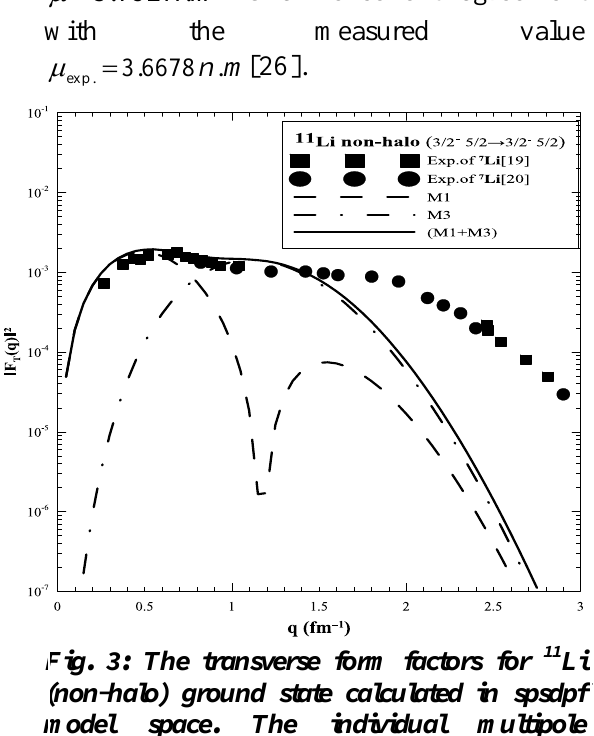
Fig. 3: The transverse form factors for 11 Li (non-halo) ground state calculated in spsdpf model space. The individual multipole contribution of M1 and M3 are shown. The data are the same as in Fig. 1.